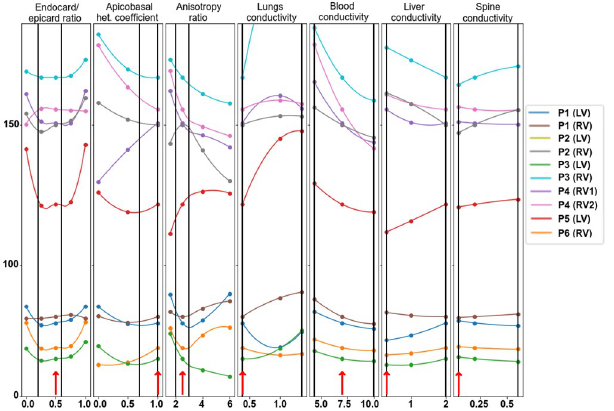
Fig 4. Dependence of the integrative distance (RED) between simulated and patient ECGs on each varied model parameter in the patient-specific models. Circle marks show the RED for the computed models at certain parameter values, and dependencies within the range intervals are interpolated. Reference parameters are annotated with red arrows near the bottom of each plot. Vertical lines indicate the physiological range of parameter variation. The 0% level indicates no difference between the model and simulated data. Color annotation indicates the patient cases (P1–P6) and the position of the electrode stimulation (LV or RV). Model P2(LV) shows outlier behavior and is excluded from the